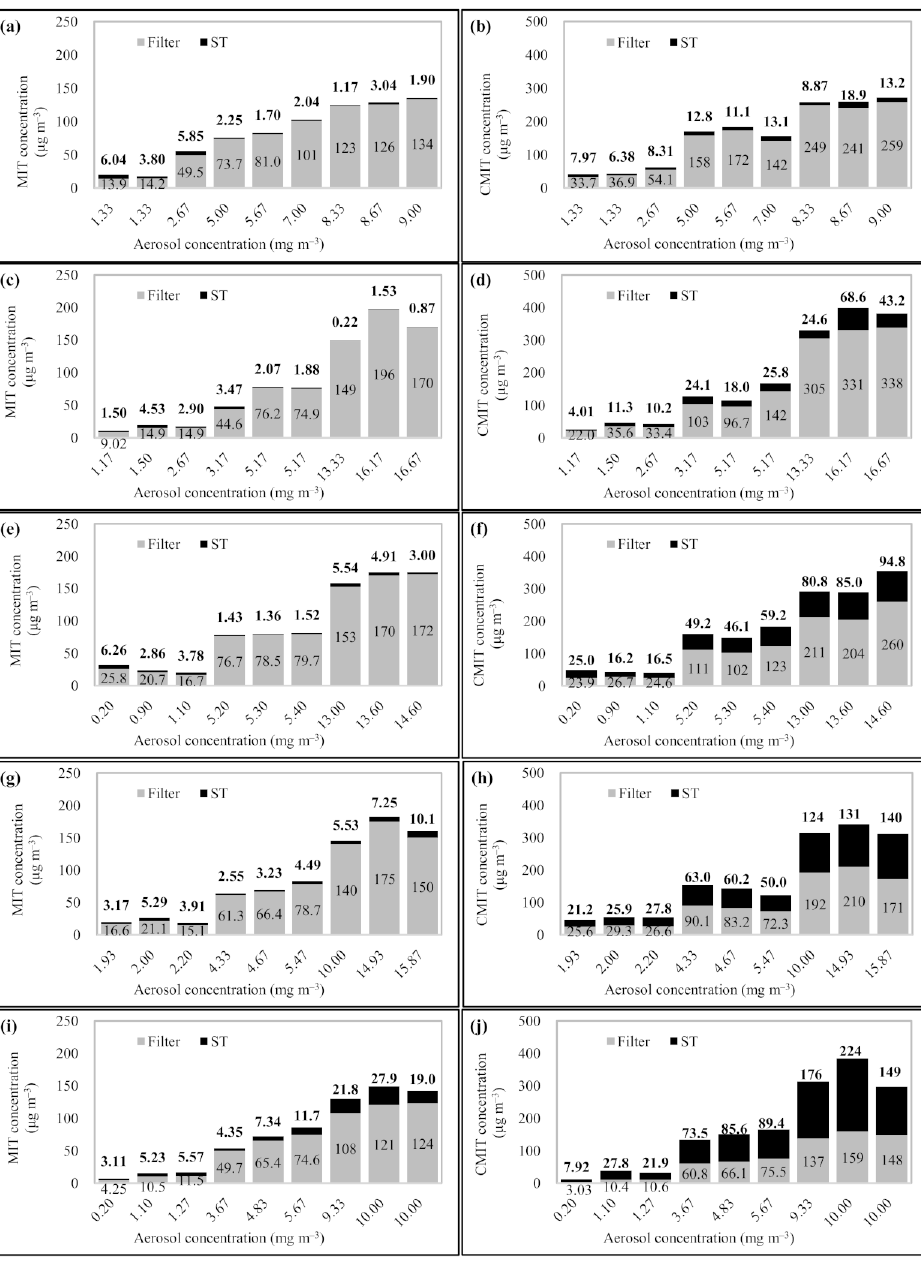
Figure 4. Results of the breakthrough test of the glass fiber filter using the CMIT/MIT aerosol samples with different sampling volume and aerosol concentrations: ( a ) sampling volume 3 L